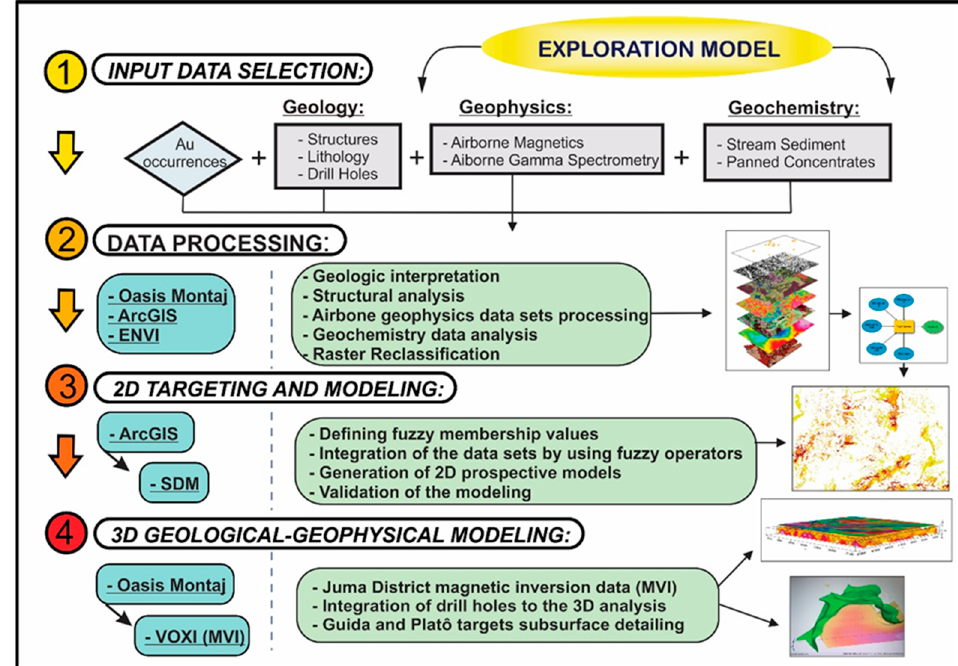
Figure 3. Flowchart illustrating the main steps and products generated for this work, based on the methodologies of Pan and Harris [51], Harris et al. [52], and modified after Nykänen [53] and Silva et al.